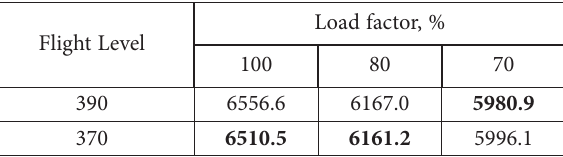
Table 6. Trip fuel in kg, 2000 km flight, ‘Deteriorated’